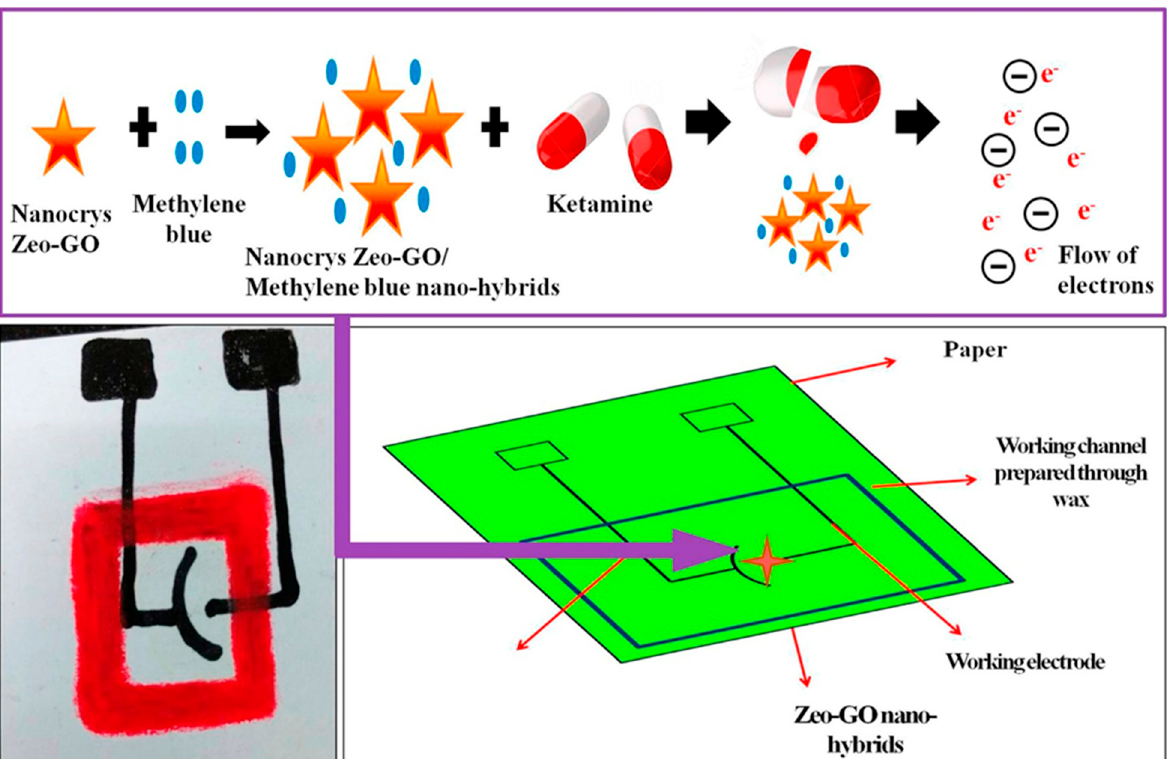
Figure 3. Schematic representation of the fabrication of the working paper-based electrode and the sensing mechanism of ketamine. Adapted with permission from ref. [75]. Copyright 2017 ELSEVIER.